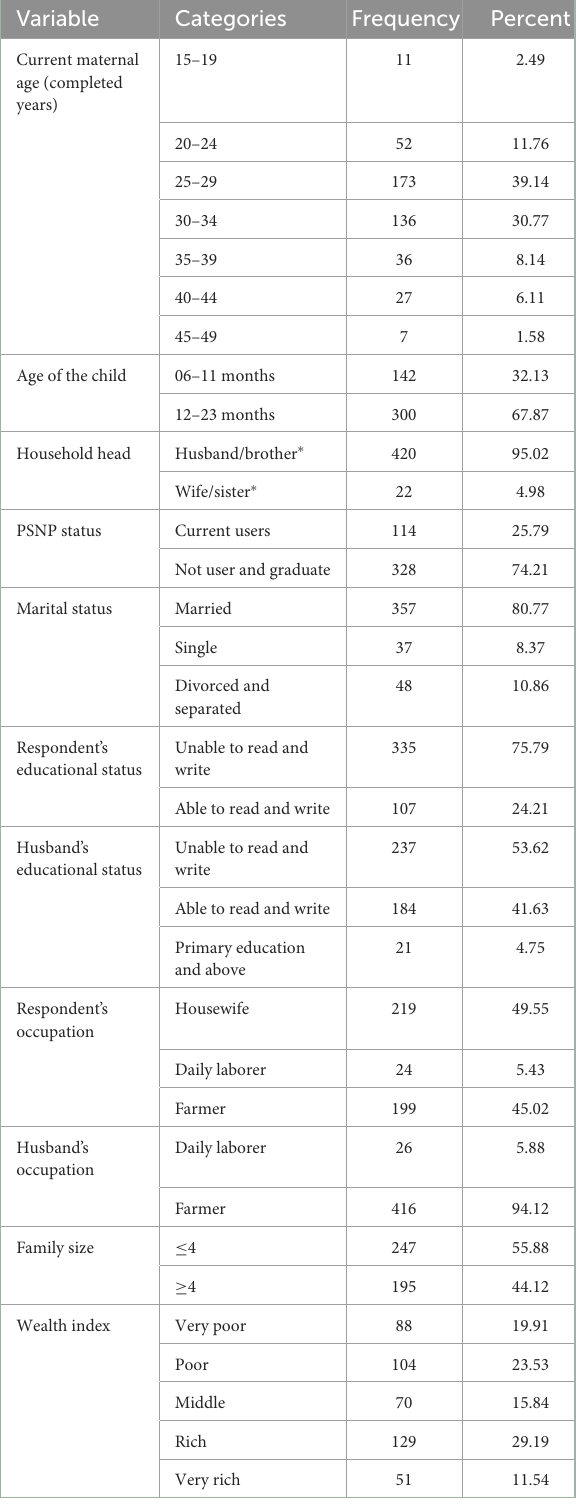
TABLE 1 Socioeconomic characteristics of the mother/caregiver of infants aged 6–23 months in South Gondar Zone, Northwest Ethiopia, 2017 ( n =